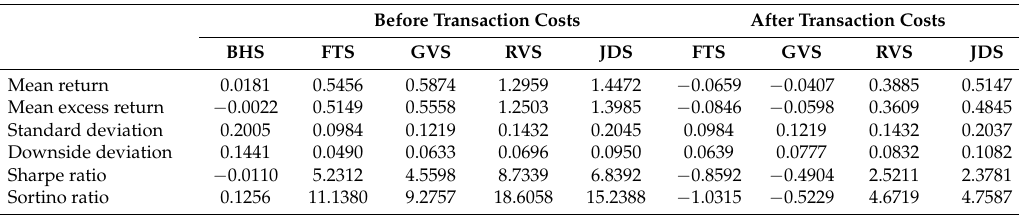
Table 4. Annualized risk-return measures for BHS, FTS, GVS, RVS, and JDS from January 1998–December 2015. Before Transaction